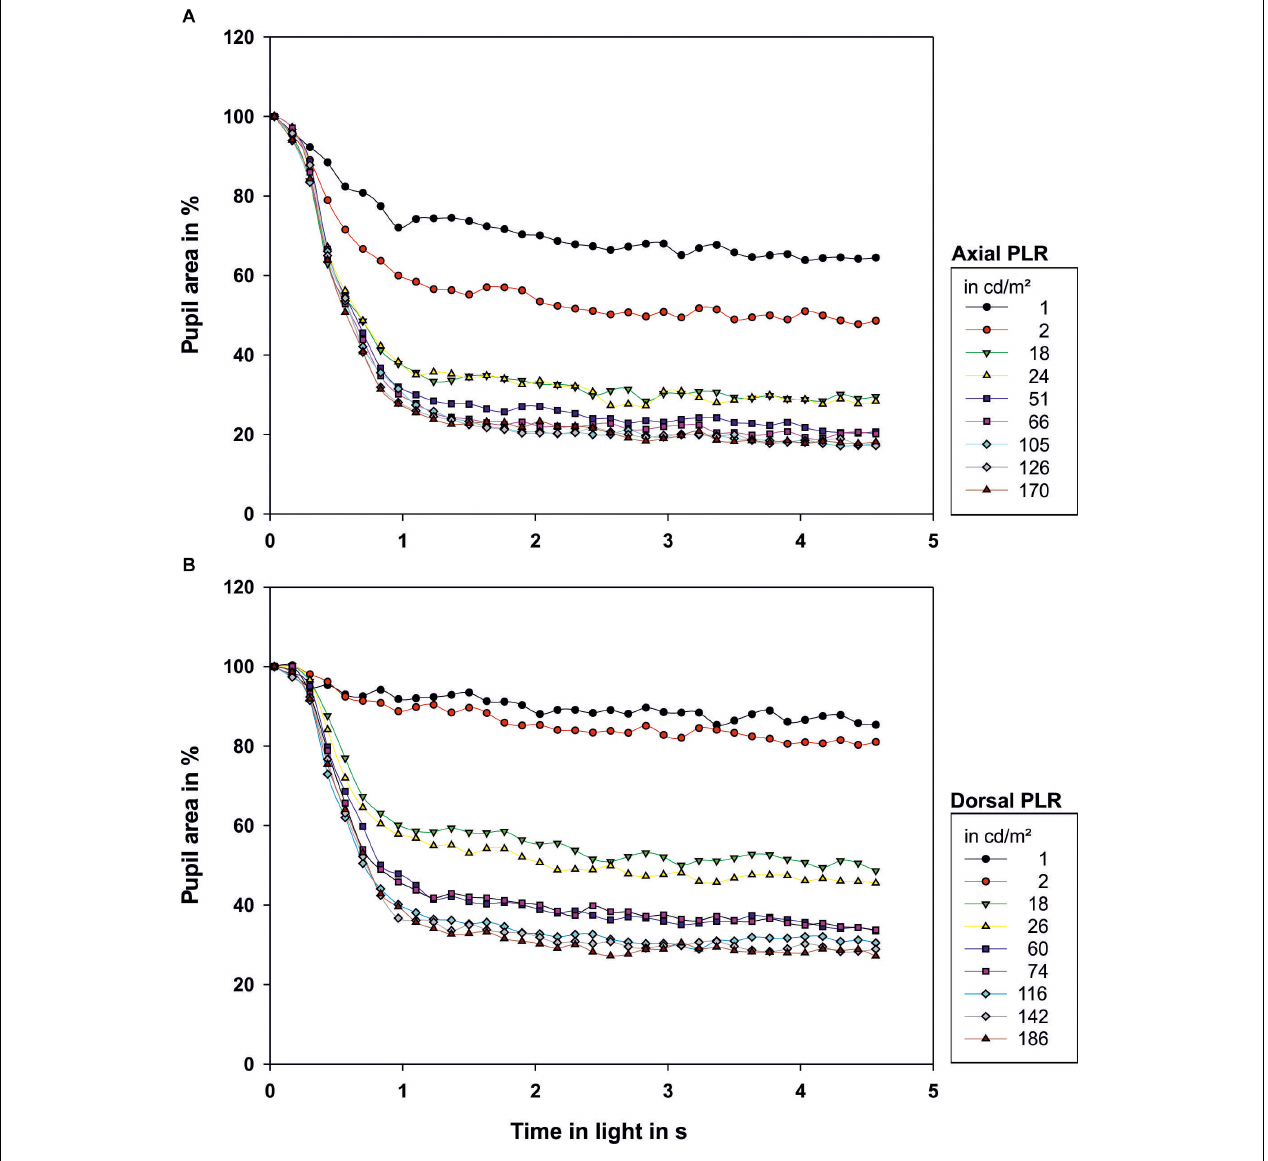
FIGURE 2 | Light reaction of the octopus pupil when (A) illuminated axially or (B) from dorsal. The area of the pupil is depicted as percentage of the area of the maximally dilated pupil at light onset. Each data point represents the mean value of the pupillary area of 3–9 measurements. The luminance of the light source in cd/m 2 measured from the distance at which the eye of the octopus had been during measurement is indicated in the legend. Light onset is zero on the time